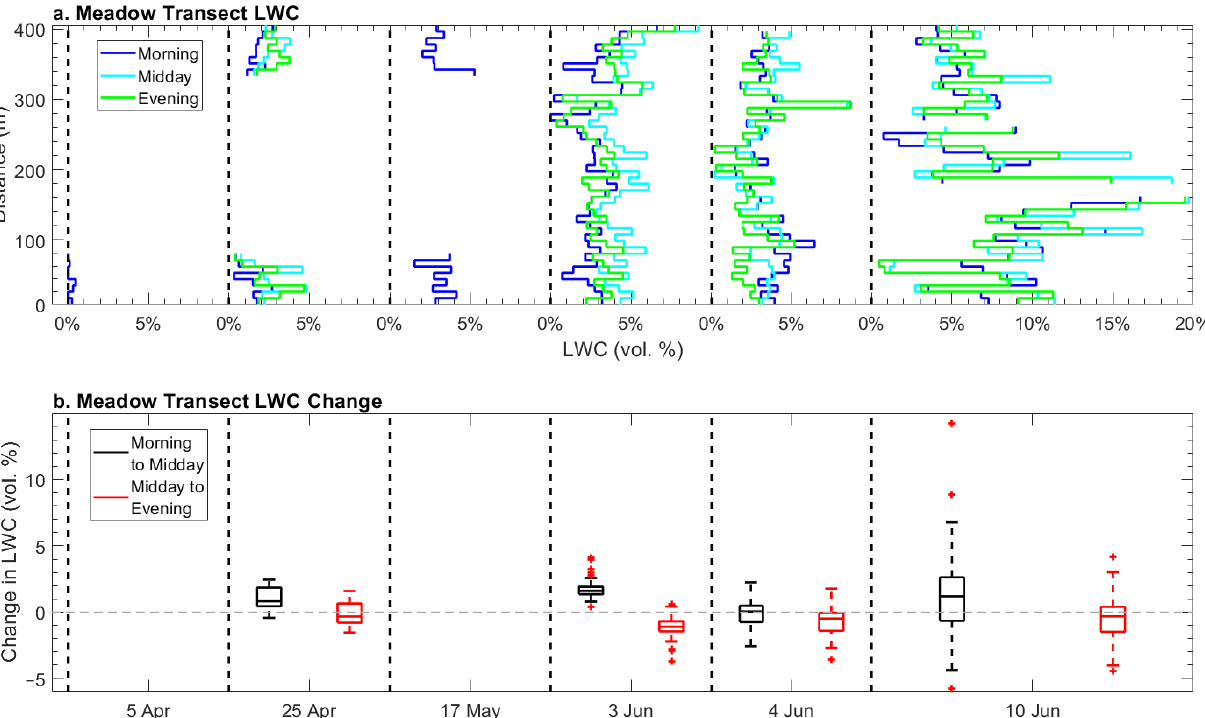
Figure 12. ( a ) Meadow Transect LWC averaged along 9 m intervals for morning, midday, and evening surveys, plotted with distance along transect. Explainable outliers were removed and are represented as breaks in the line. ( b ) Box plots of ∆ LWC along the Meadow Transect from morning to midday and from midday to evening. Positive values represent an increase in LWC, and negative values represent a decrease in LWC.